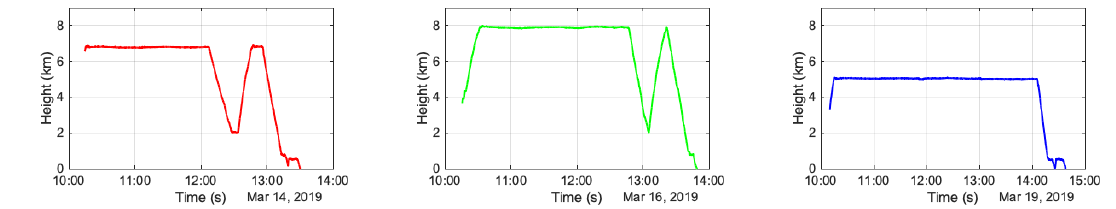
Figure A1. Flight height of the aircraft on each observation day.